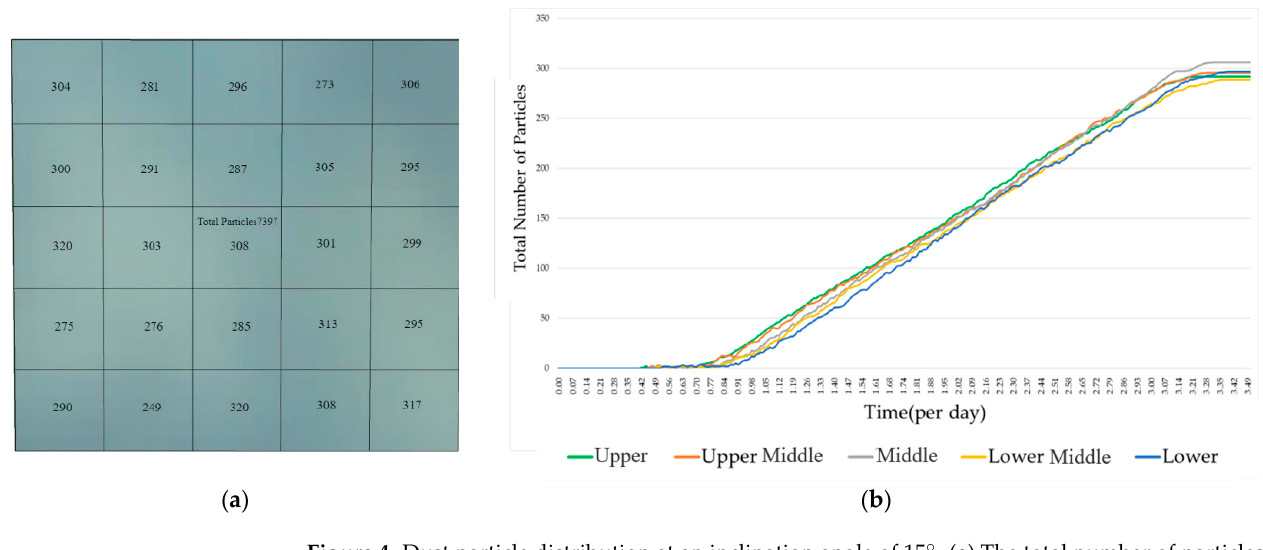
Figure 4. Dust particle distribution at an inclination angle of 15°. ( a ) The total number of particles in each area and ( b ) that over time on the solar panel surface.